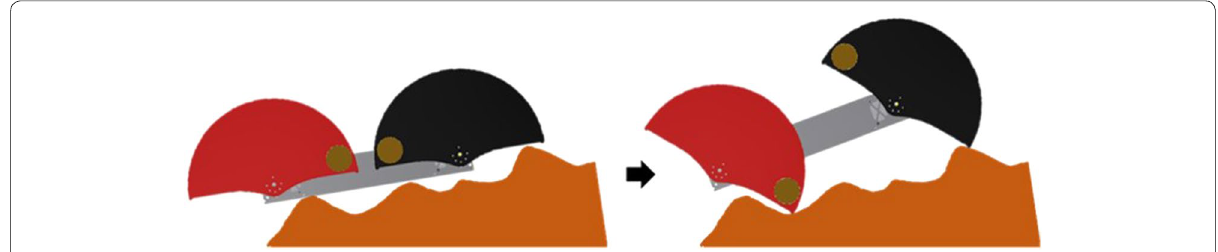
Fig. 3 Phase change of butterfly gait